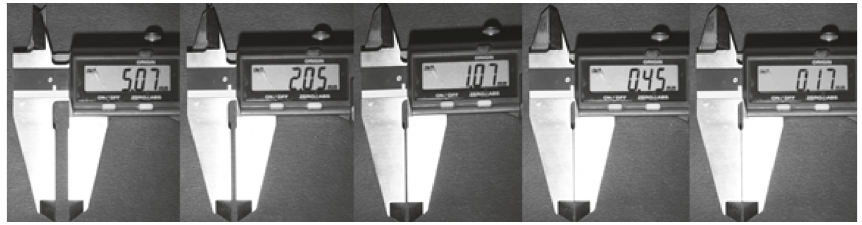
Figure 2: Sizes of the five different gaps between two jaws of the